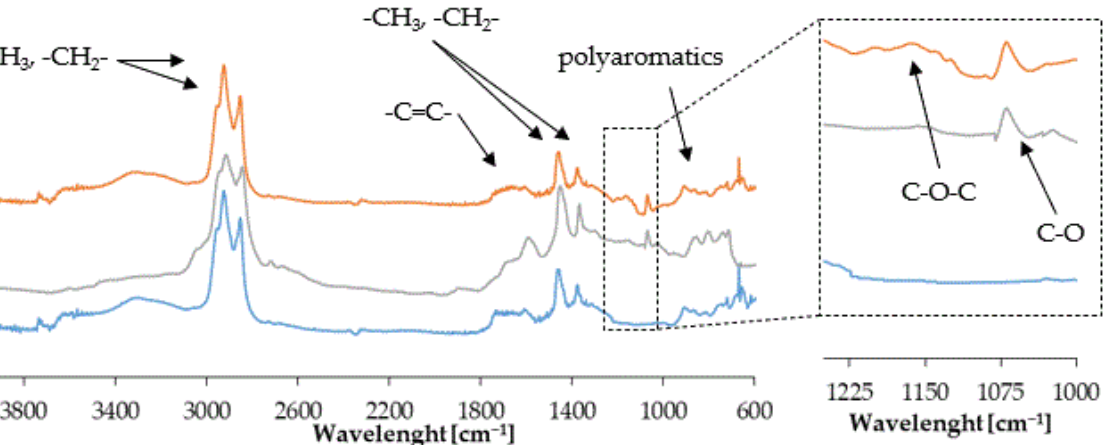
Figure 5. Infrared spectra of the control bitumen (blue line), bitumen modified with biopolymer (grey line), and bitumen modified with biopolymer in presence of crosslinking agent (orange line).